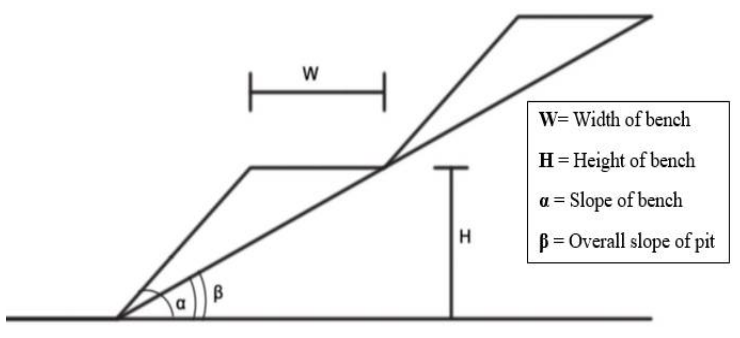
Figure 1. Design parameters in rock slope (Adapted from [14]).